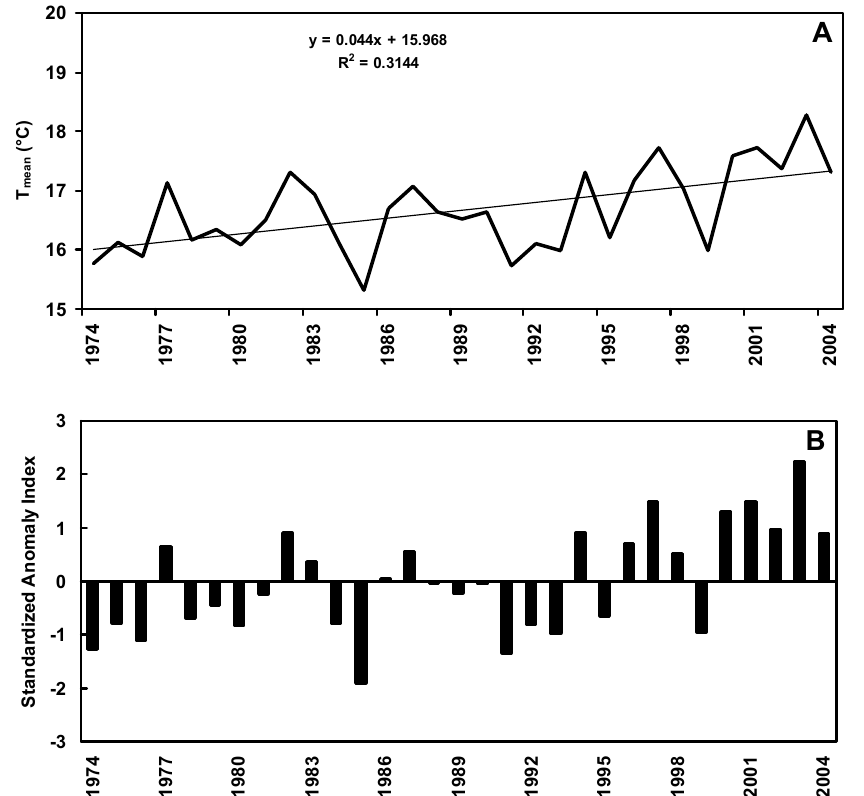
Figure 1. Trend of mean annual air temperatures ( A ) and Standardized Anomaly Index, SAI ( B ) over the period 1974–2004 at the AGRIS experimental station “S. Michele” (Southern Sardinia, Italy).